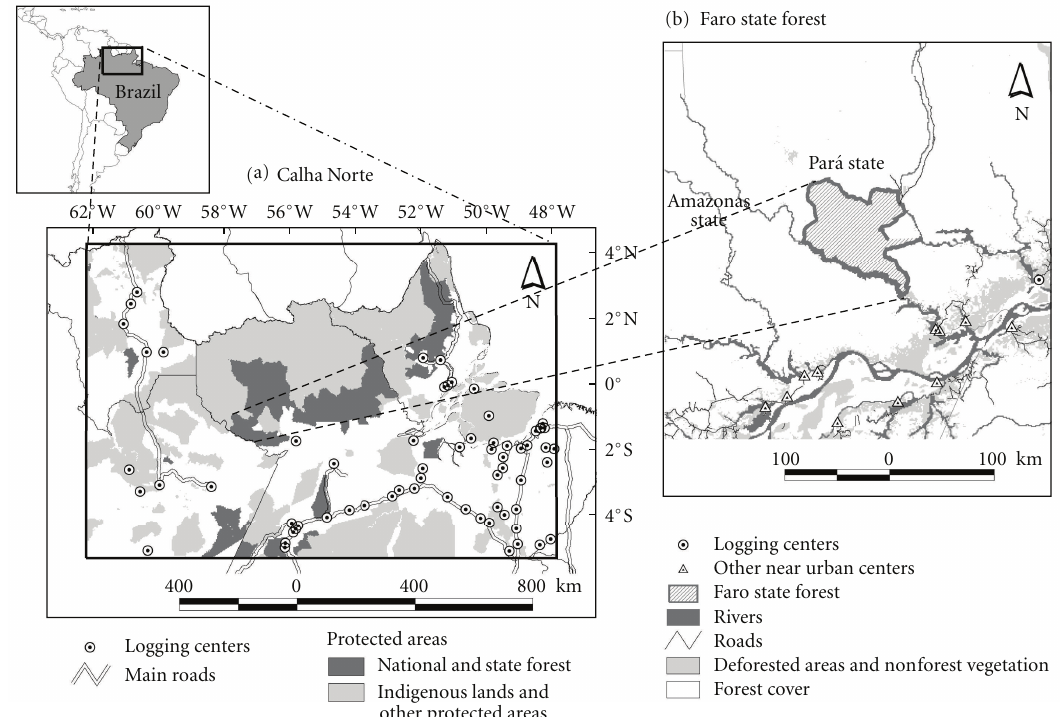
Figure 1: The Calha Norte region and Faro State Forest, Par´a State,